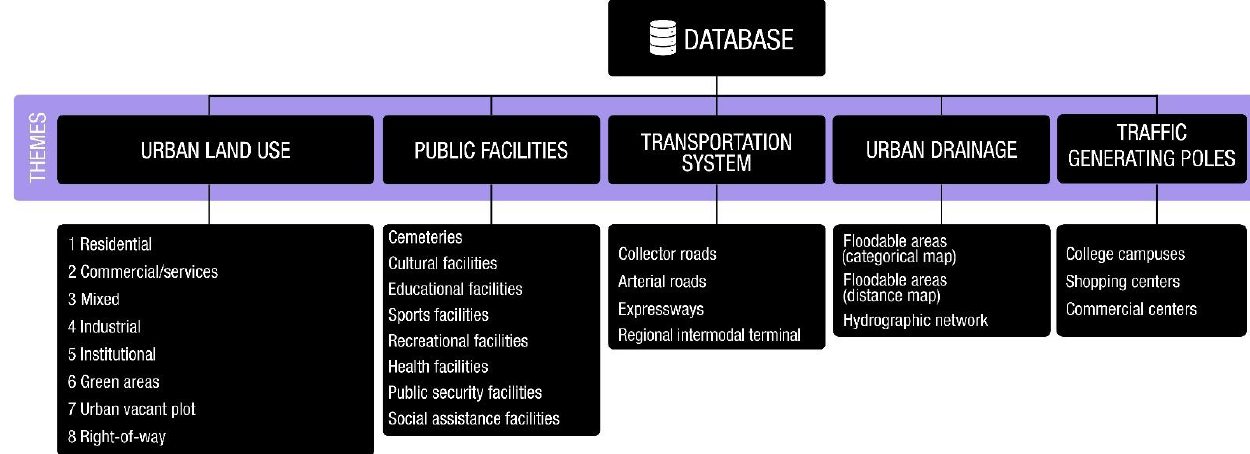
Figure 2. Database framework.